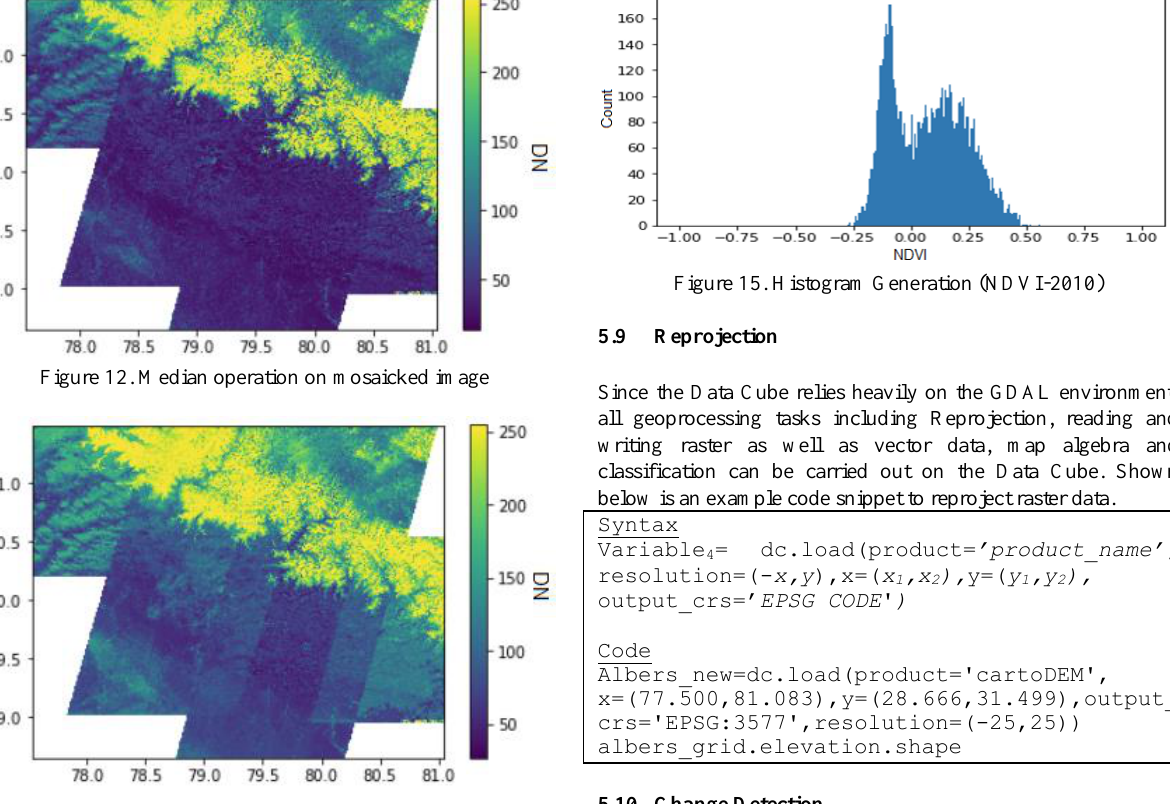
Figure 13. Mean operation on Mosaicked image